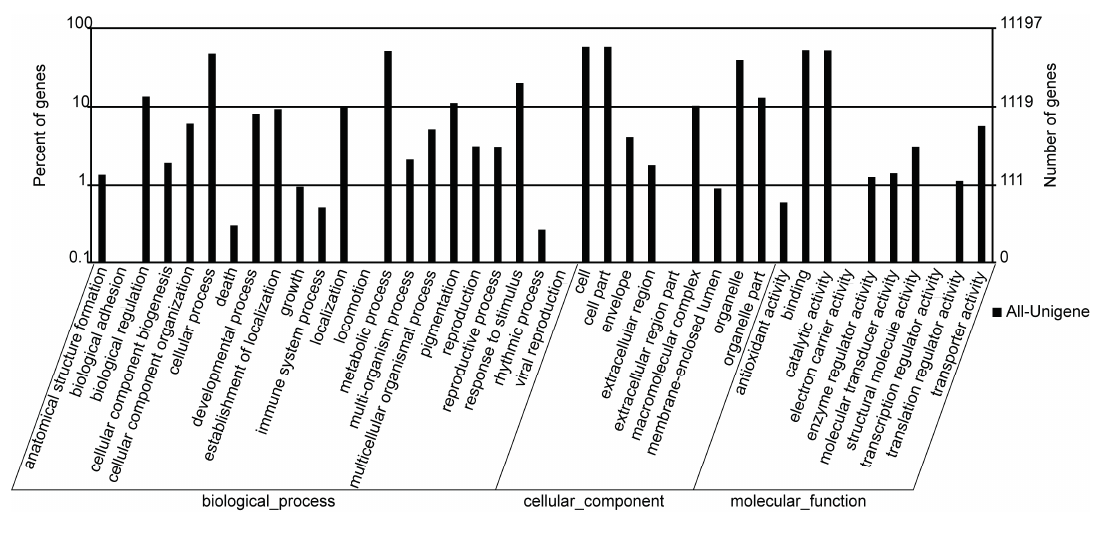
Figure 2. Gene Ontology (GO) classification for all unigenes. All unigenes were aggregated into three main categories: biological process, cellular component and molecular function. Percentages are based on the proportion and number of genes in each set.